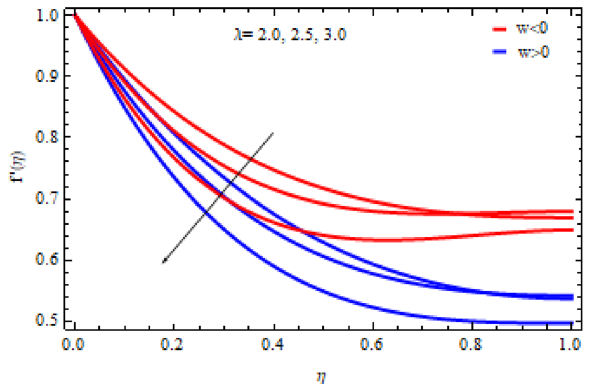
Figure 8. Velocity field by (cid:31) .